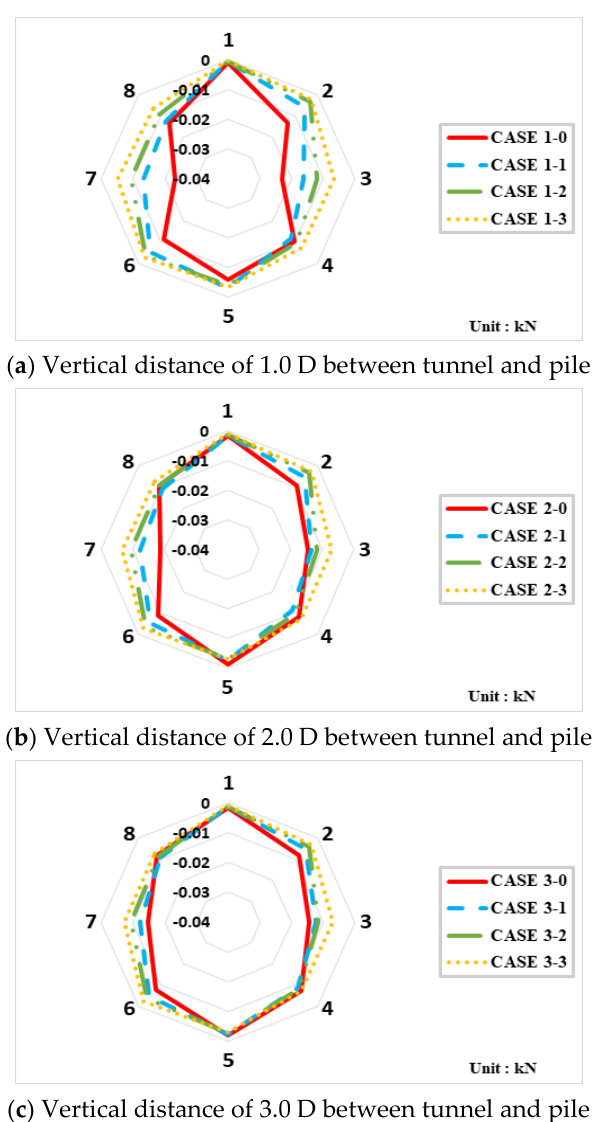
Figure 14. Axial force on tunnel by ultimate load in model test.